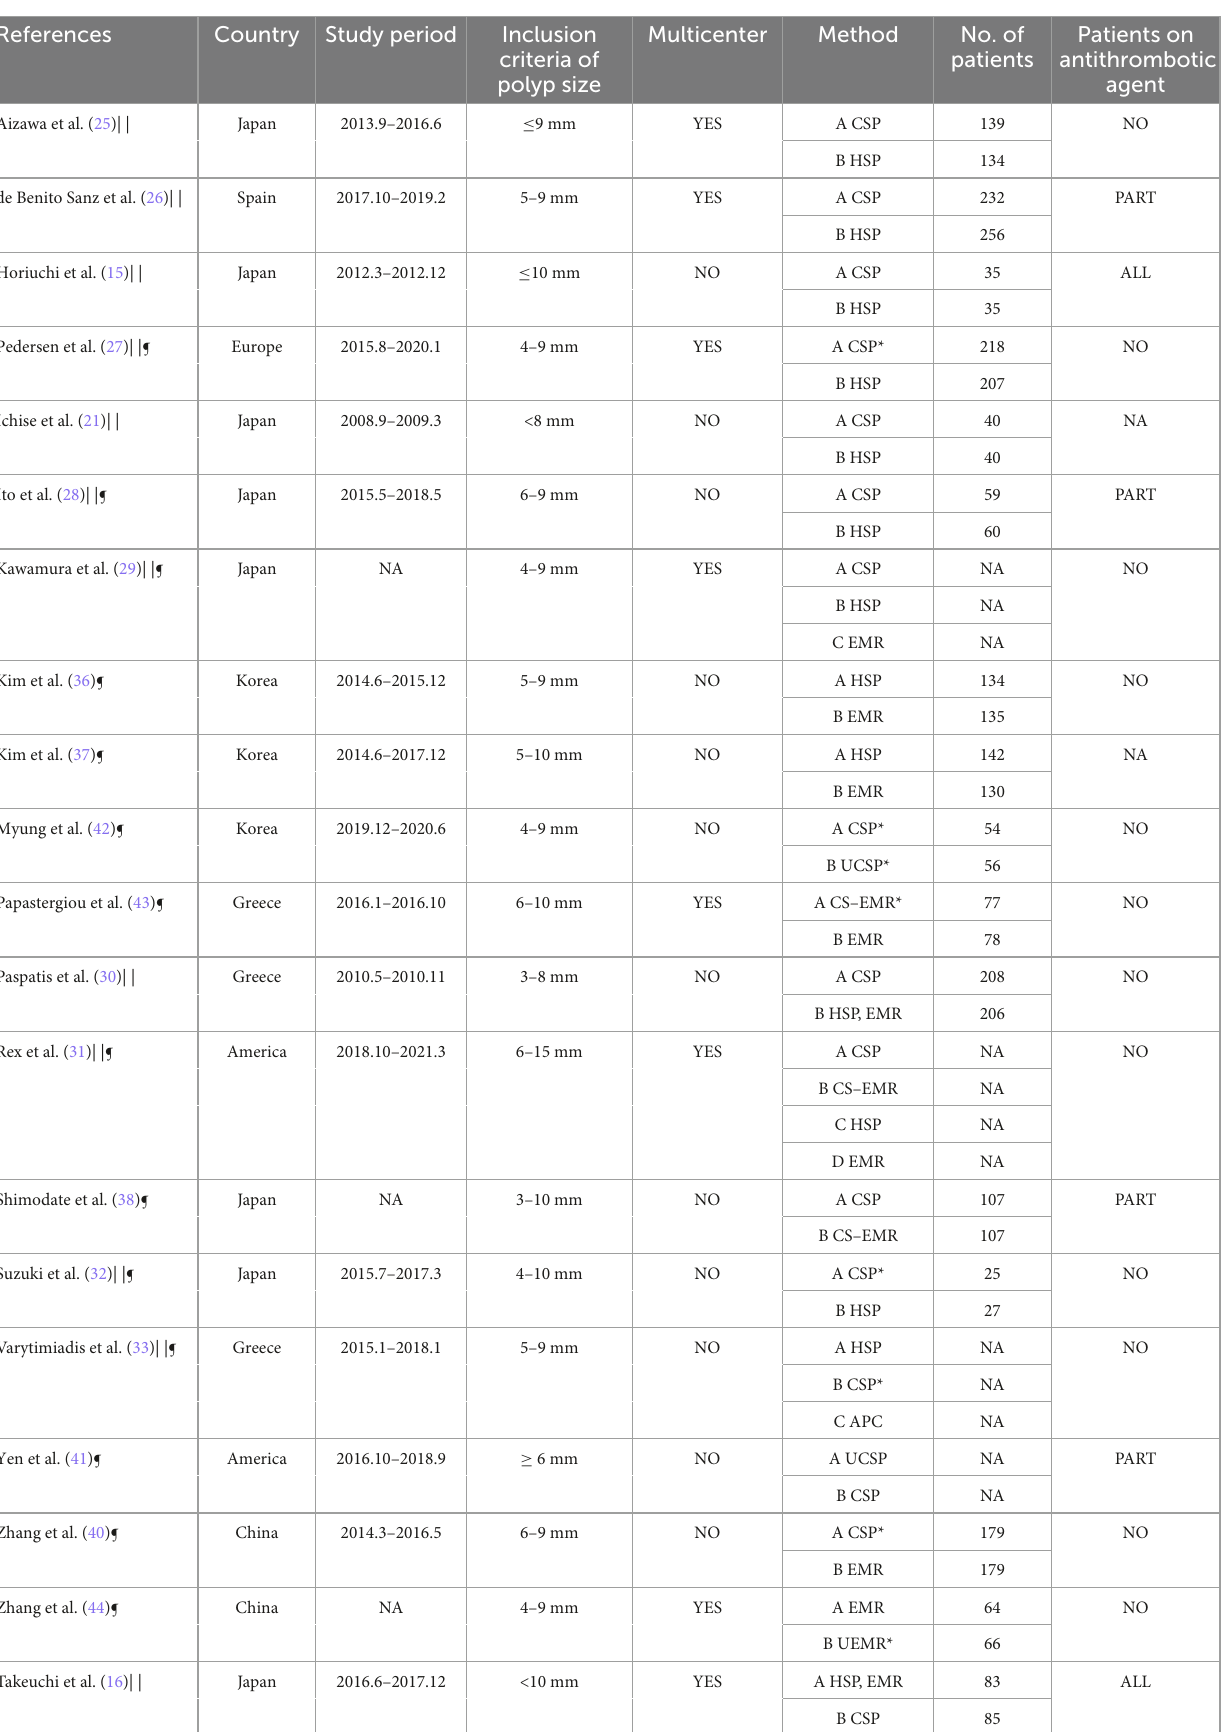
TABLE 1 Characteristics of included randomized controlled